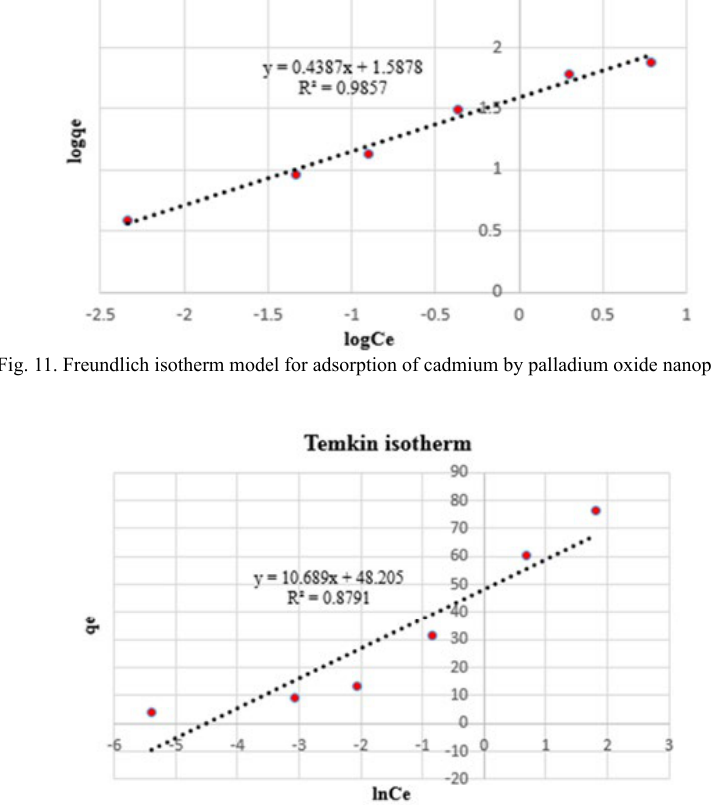
Fig 12. Temkin isotherm model for adsorption of cadmium by palladium oxide